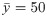
Adaptation in feedback (FB) and incoherent feedforward (IFF) architectures.A. Cartoon representation of FB and IFF architectures. Input u positively regulates species X and Y (black arrows). X inhibits the production of both X and Y in the FB architecture (red line, left panel) and mediates the degradation of Y (negative regulation) in the IFF architecture (red line, right panel). Both X, Y degrade at rates proportional to their respective populations (black arrows). B. Illustration of coupled and decoupled production. X and Y represent genes whose expression is under the control of the same promoter, but their production is considered coupled only if they are on the same transcript. C. Product inhibition functions considered in the FB implementations. D. The distribution of y at steady state for different values of regulation strength α. As the strength of regulation α increases, the distribution of y gets tighter around the nominal value y¯=50. u is a Poisson distribution with mean u¯=10. The distribution is the same distribution for both FB and IFF, with g = gR used for FB.E. The distribution of y at steady state for different classes of inhibition functions, gR and gH. F. Circuit response to white noise. ‖G‖H22 is shown by black stars (for FB) and red stars (for IFF). The bars show the corresponding variance of y(t) of 10000 sample runs at t = 20. The noise in u modeled by adding 50[1,1]Tw˙ to the right-hand side of the ODE models, where w˙ is the standard Brownian motion.G, H Circuit response to input u given by a birth-death process (with birth rate br = 10 and death rate 1). Left panel shows sample trajectory in response to u for different gain implementations. Right panel shows the empirical probability distribution derived from each sample trajectory until final time t = 1000. Panel G shows the response of FB implementations using g = gH and panel H that of IFF implementations. I. Log plot of the coefficient of variation (cv) of sampley-trajectories in response to u given by a birth-death process with birth rate br and death rate 0.1br (t ∈ [0, 1000]). Parameters used in D-I: u¯=10, k1 = l1 = 5, l2 = 1, f(u) = 5u. For gH≔111+10(x/10)n, n = 1.1 (for α = 1), n = 11(for α = 10), n = 110 (for α = 100).